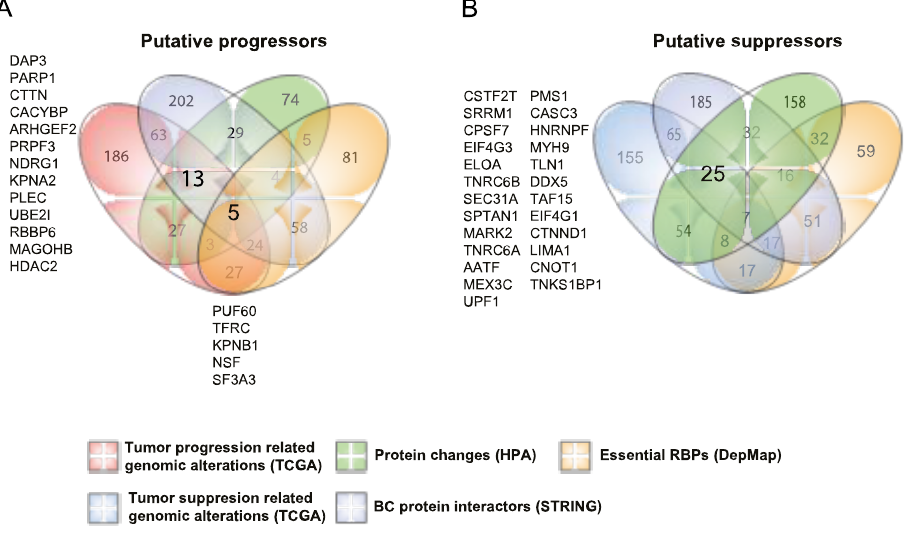
Figure 7. Detecting putative breast cancer RNA-binding proteins. ( A ) A Venn diagram depicting the number of unique and shared RBPs across the four cancer-progression profiles. ( B ) A Venn diagram showing the number of unique and shared RBPs across the four cancer-suppression profiles.